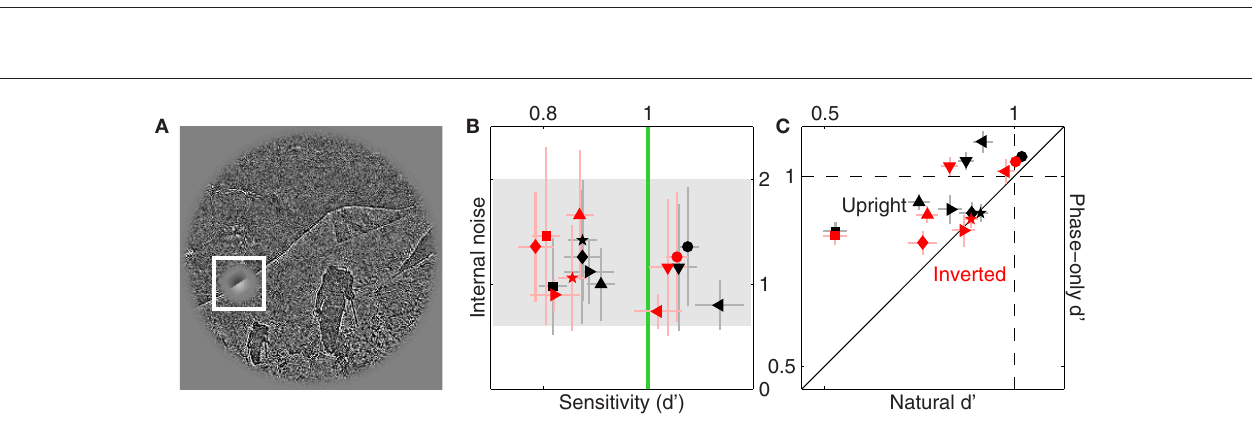
Figure 7 | effect of spatial cueing on filter shape. (A,B) Are plotted to the same conventions of Figure 5C , but report data for precue and postcue trials separately. (C) Plots all oddity (solid) and target similarity (open) estimates across conditions and observers for precue ( y axis) versus postcue ( x axis). Axis labels for target similarity in (C) are shown